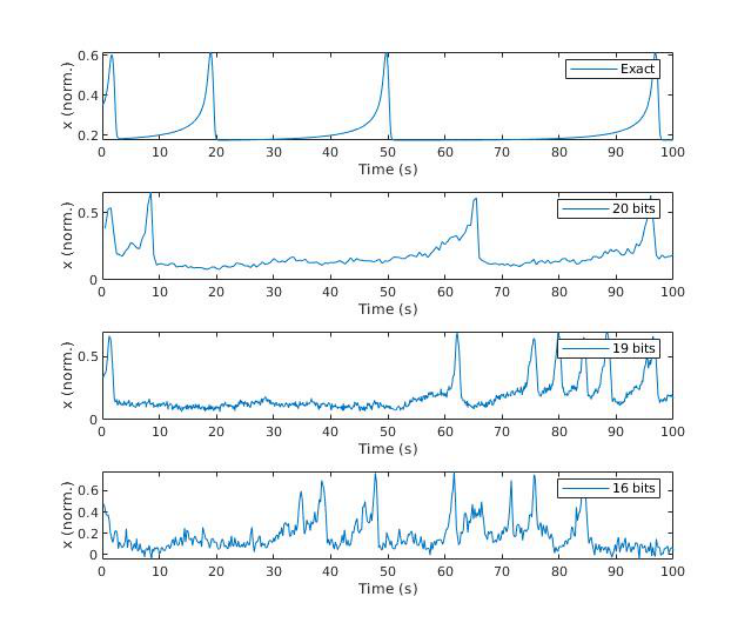
Figure 3. Temporal evolution of the x variable in the HR model, using conventional arithmetic (top, “exact”), and stochastic computing (20, 19, 16 bits).